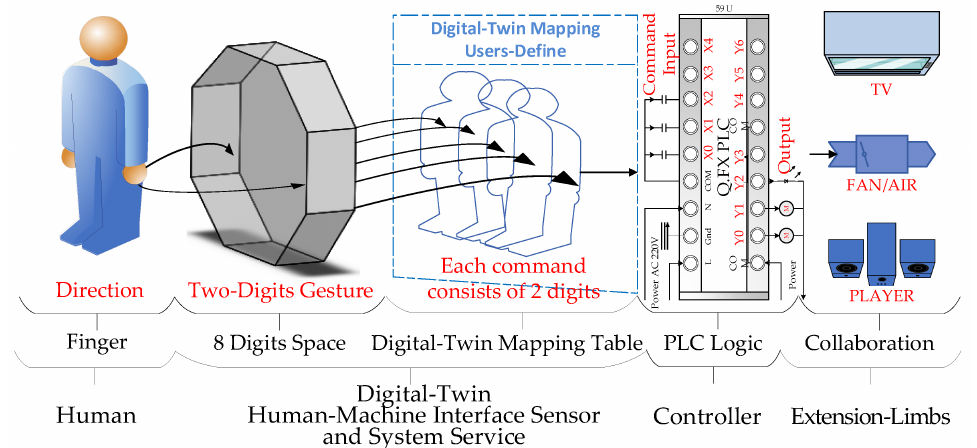
Figure 1. The process of transforming DT-HMIS into instruction control commands or reassembling